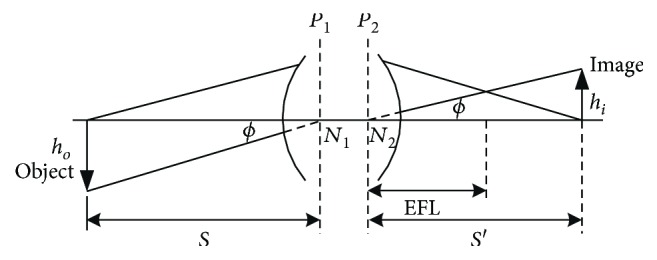
Schematic of the image and object in relation to each other.